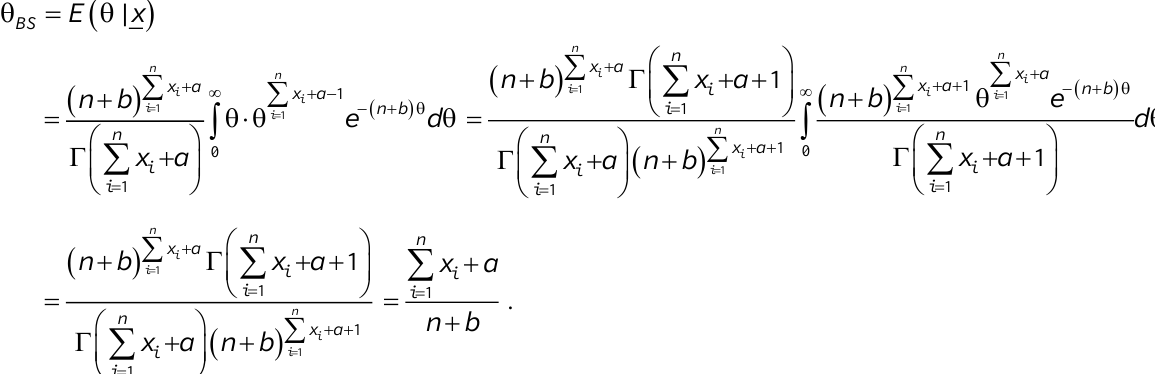
The Bayesian estimator of 𝜃 under the squared error loss function is shown by,